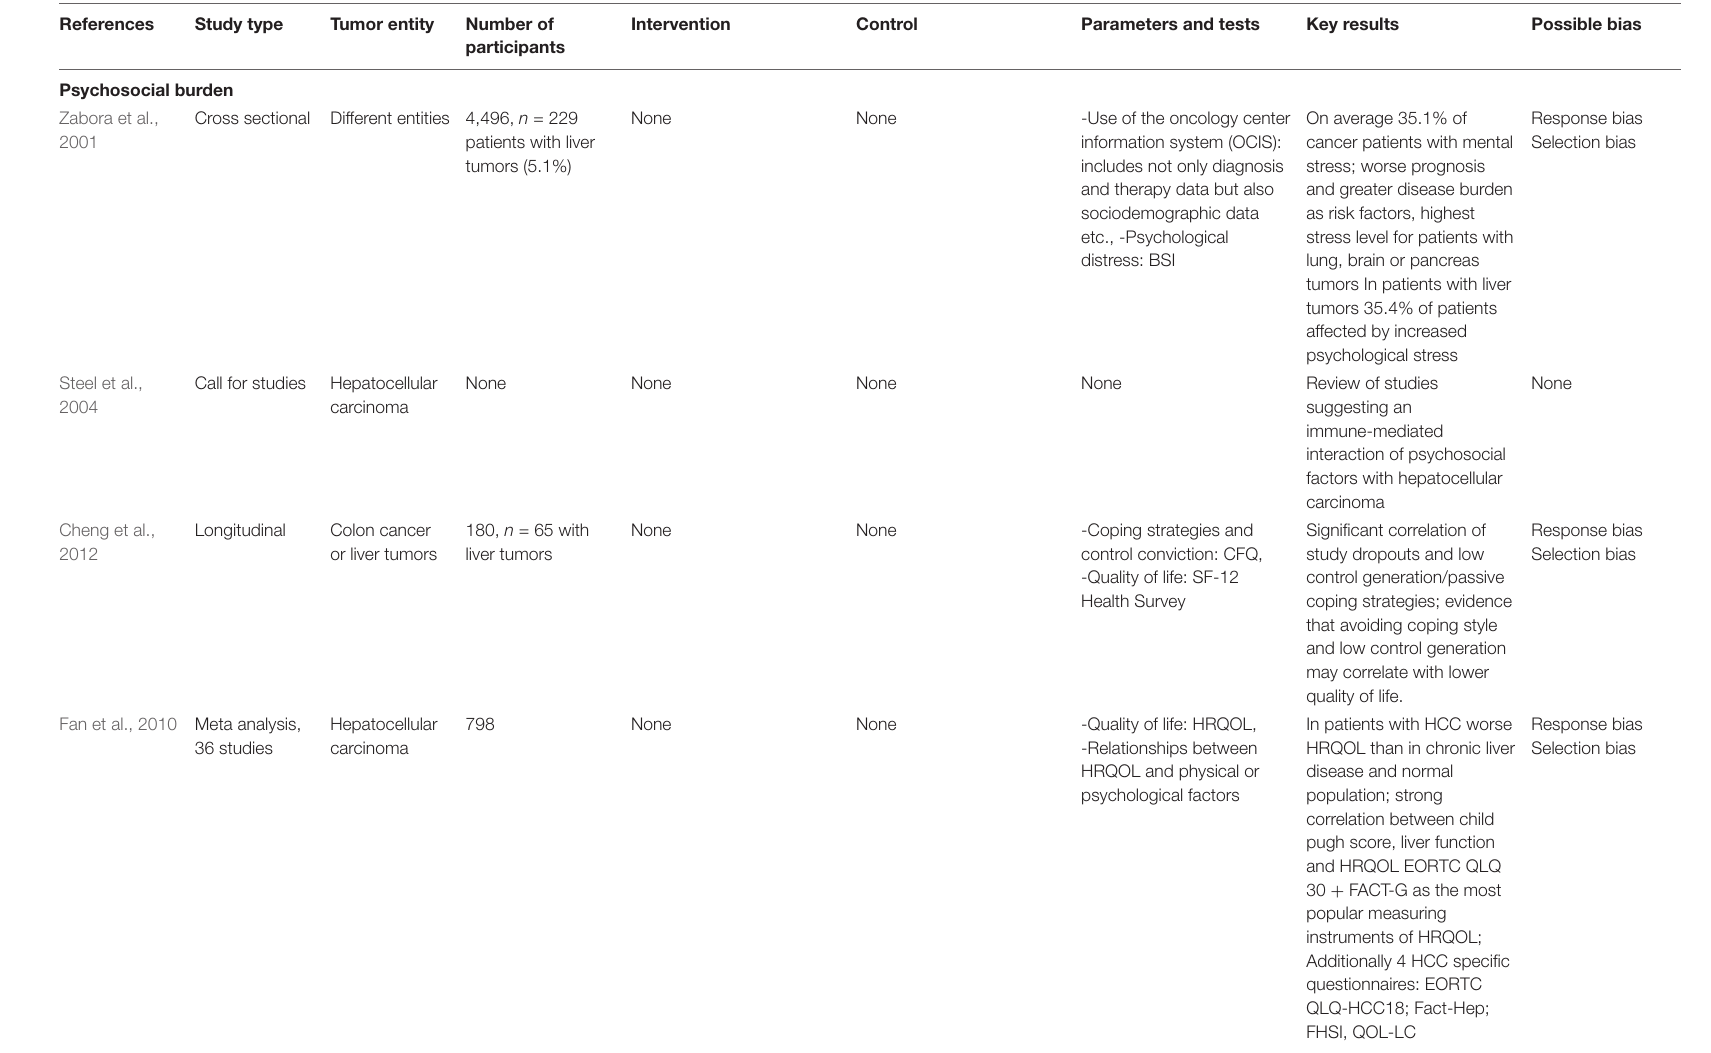
TABLE 2 | List of studies included in the